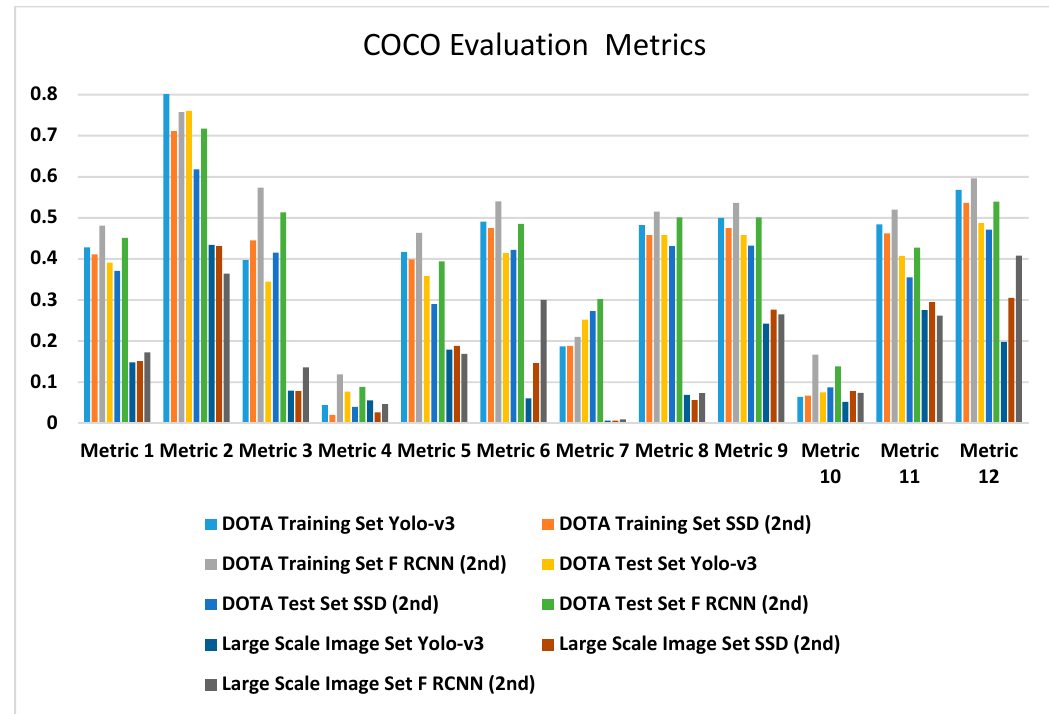
Figure 9. Graphic representation of COCO evaluation metrics.